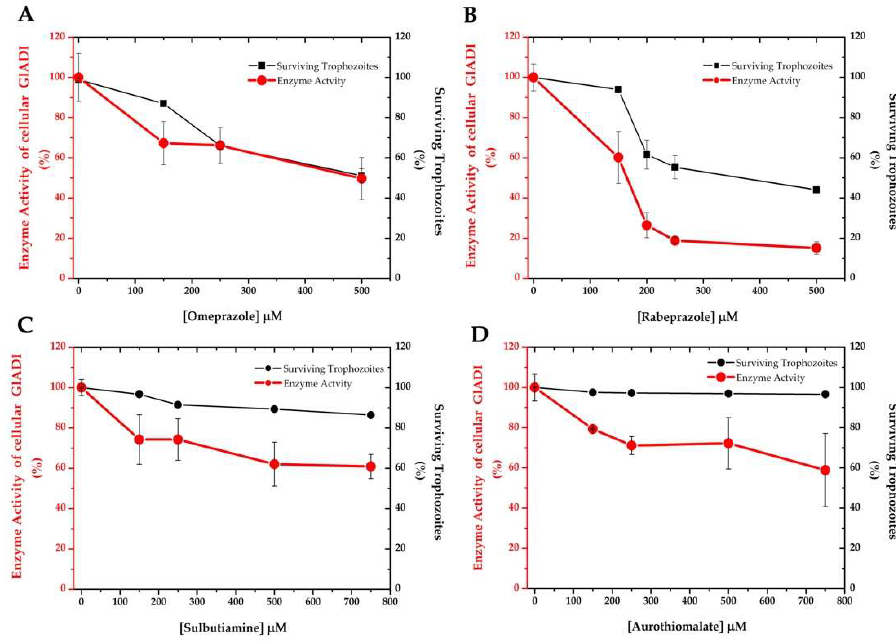
Figure 6. Effect of repurposing drugs on Giardia trophozoite survival and on the enzyme activity of endogenous GlADI. Omeprazole and rabeprazole exerted a concomitant effect on these parameters ( A , B ), whereas sulbutiamine and aurothiomalate did not ( C , D ).